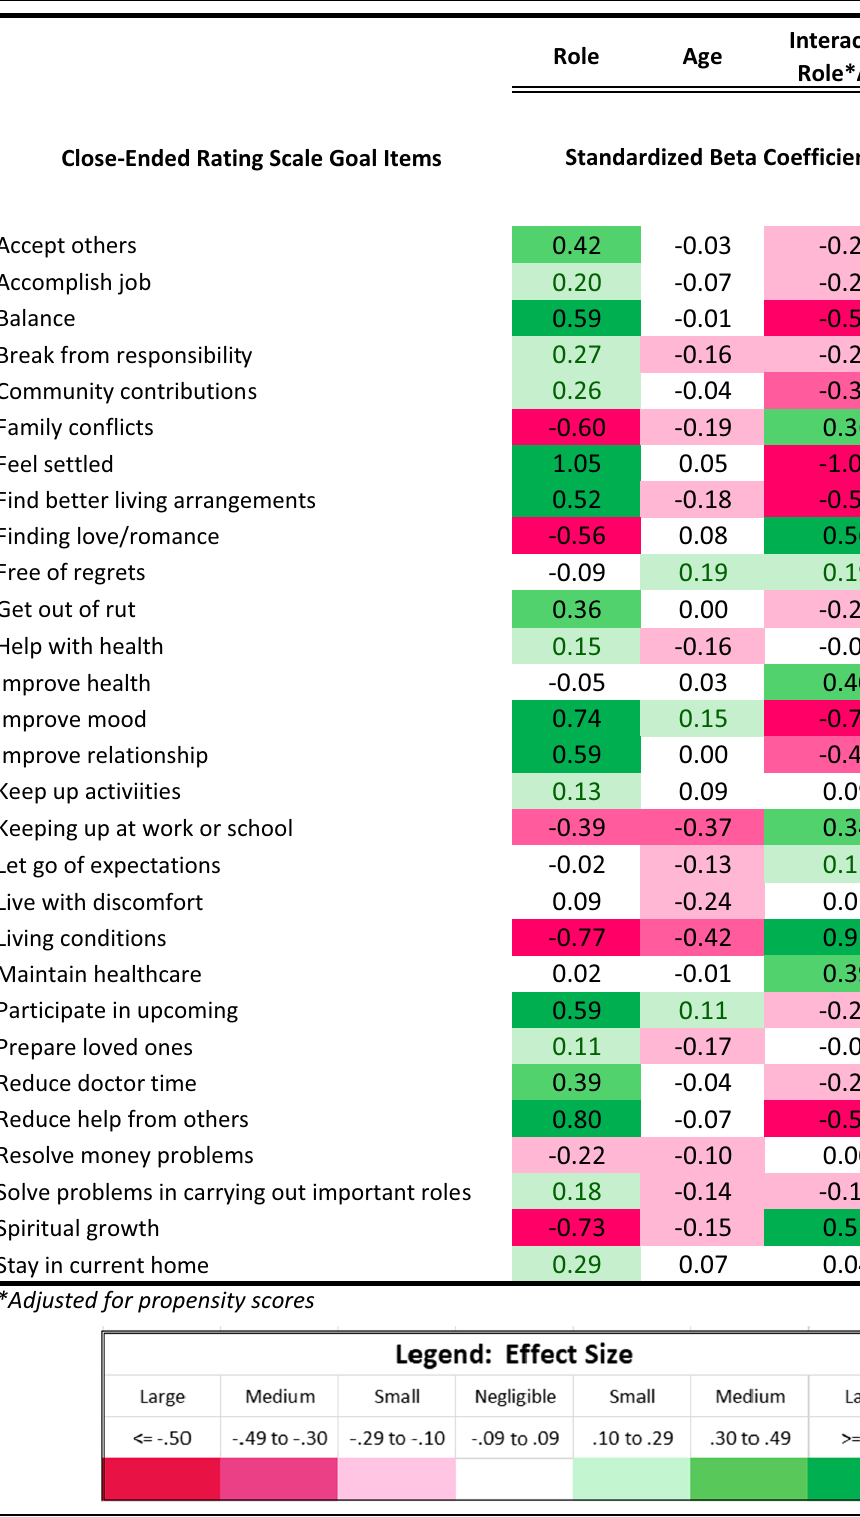
Table 5 Results of patient vs. comparison groups’ ANCOVA models predicting close-ended goal